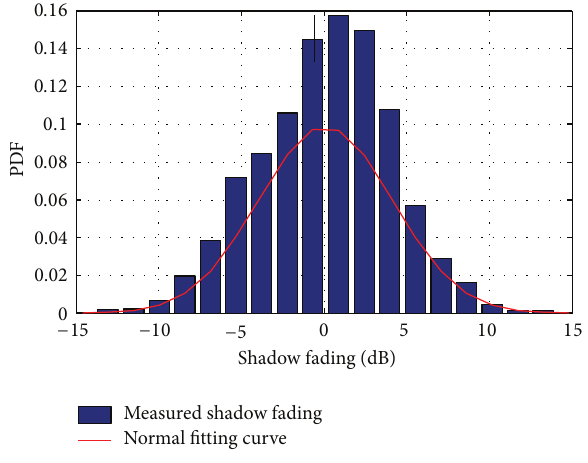
Figure 4: PDF of shadow fading in hilly terrain.